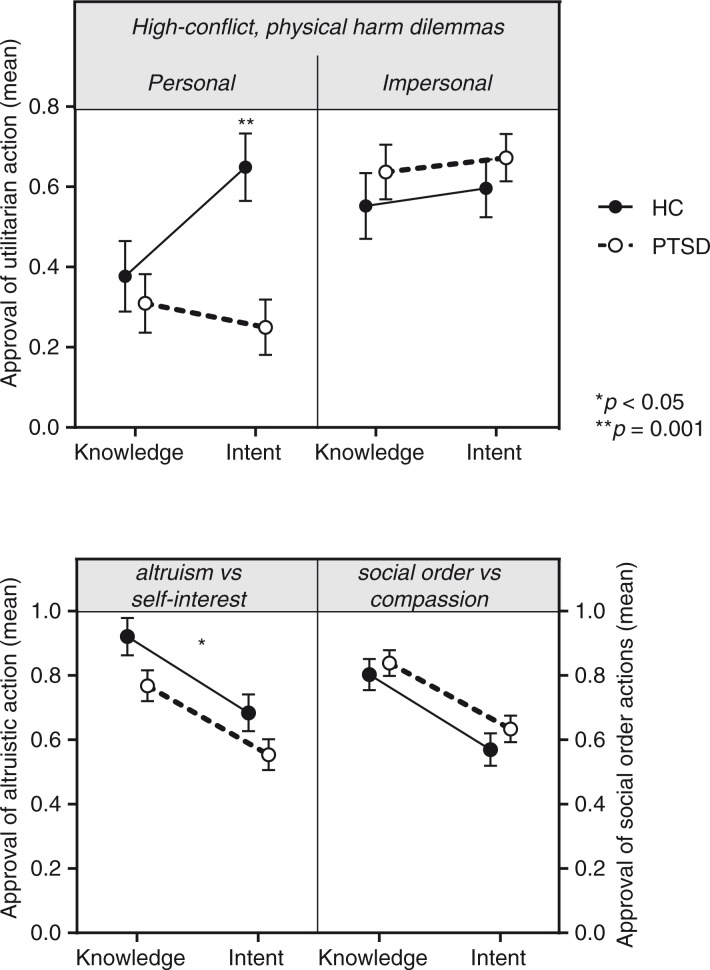
Mean approval rates of moral dilemmas in patients with PTSD compared to HC.